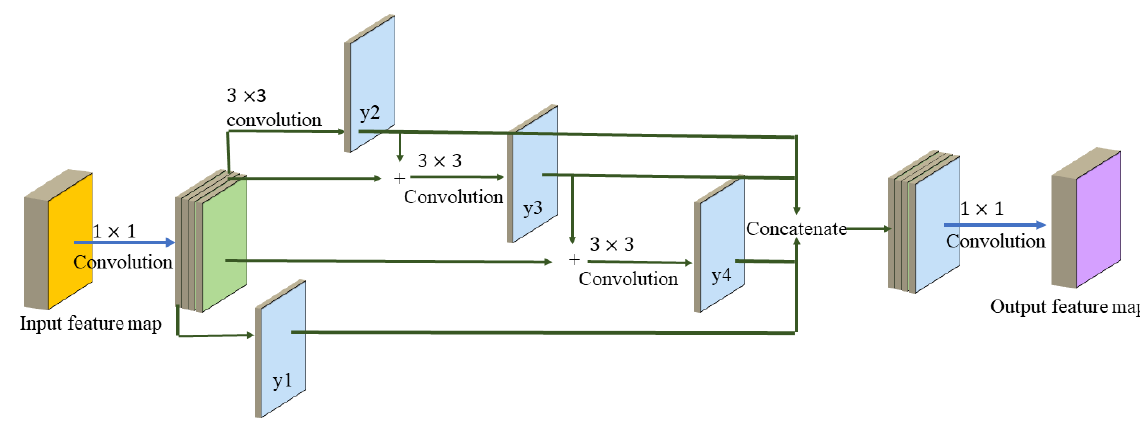
Figure 4. Residual module, where “+” indicates the addition of two feature maps.